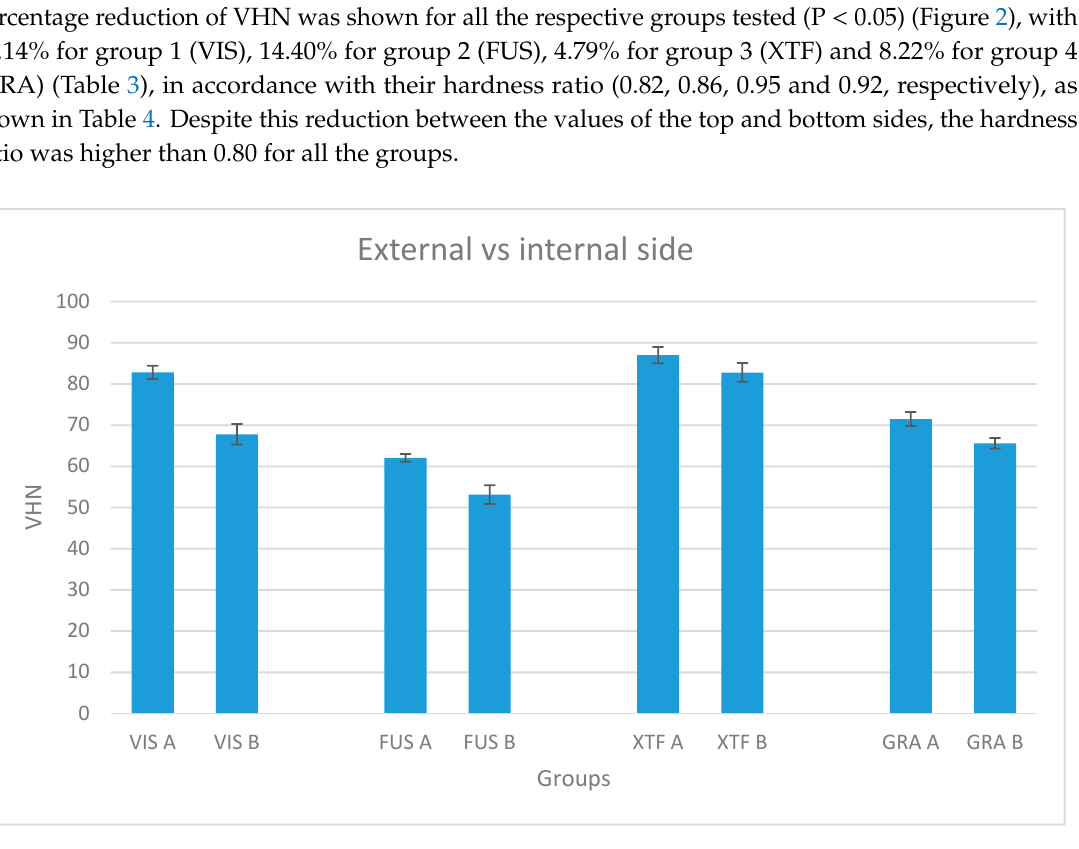
Table 2. Descriptive statistics of VHN for each tested material, considering both the external and the internal side of the samples.